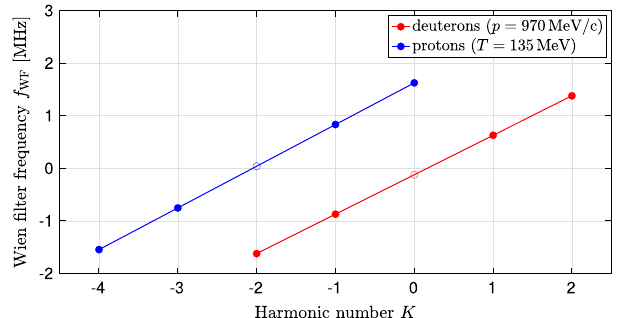
FIG. 3. Frequencies of the rf Wien filter for different harmonics for proton (at T ¼ 135 MeV) and deuterons from Eq. (37). The frequencies shown by open symbols (deuterons at K ¼ 0 , and protons at K ¼ − 2 ) are not reachable with the present setup of the driving circuit of the rf Wien